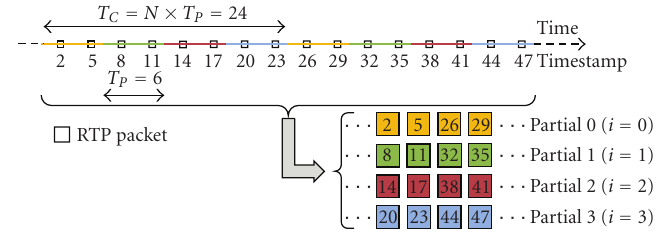
Figure 6: RTP stream partitioning.